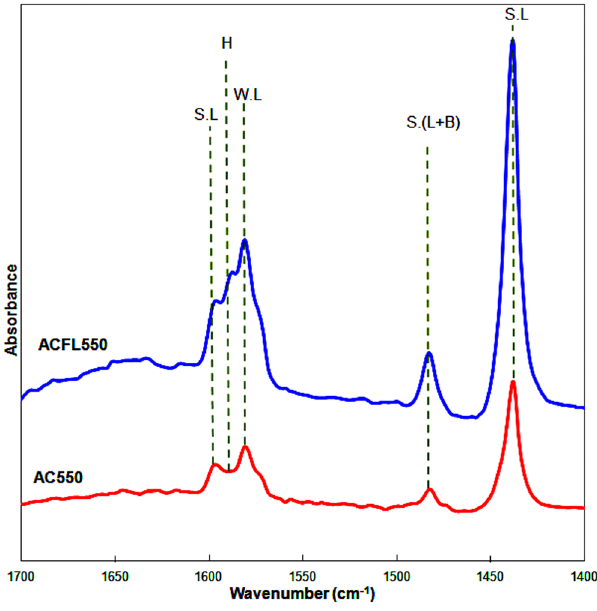
Figure 4. FTIR-Pyridine spectra in the regionof 1400–1700 cm − 1 for ACFL550 and AC550